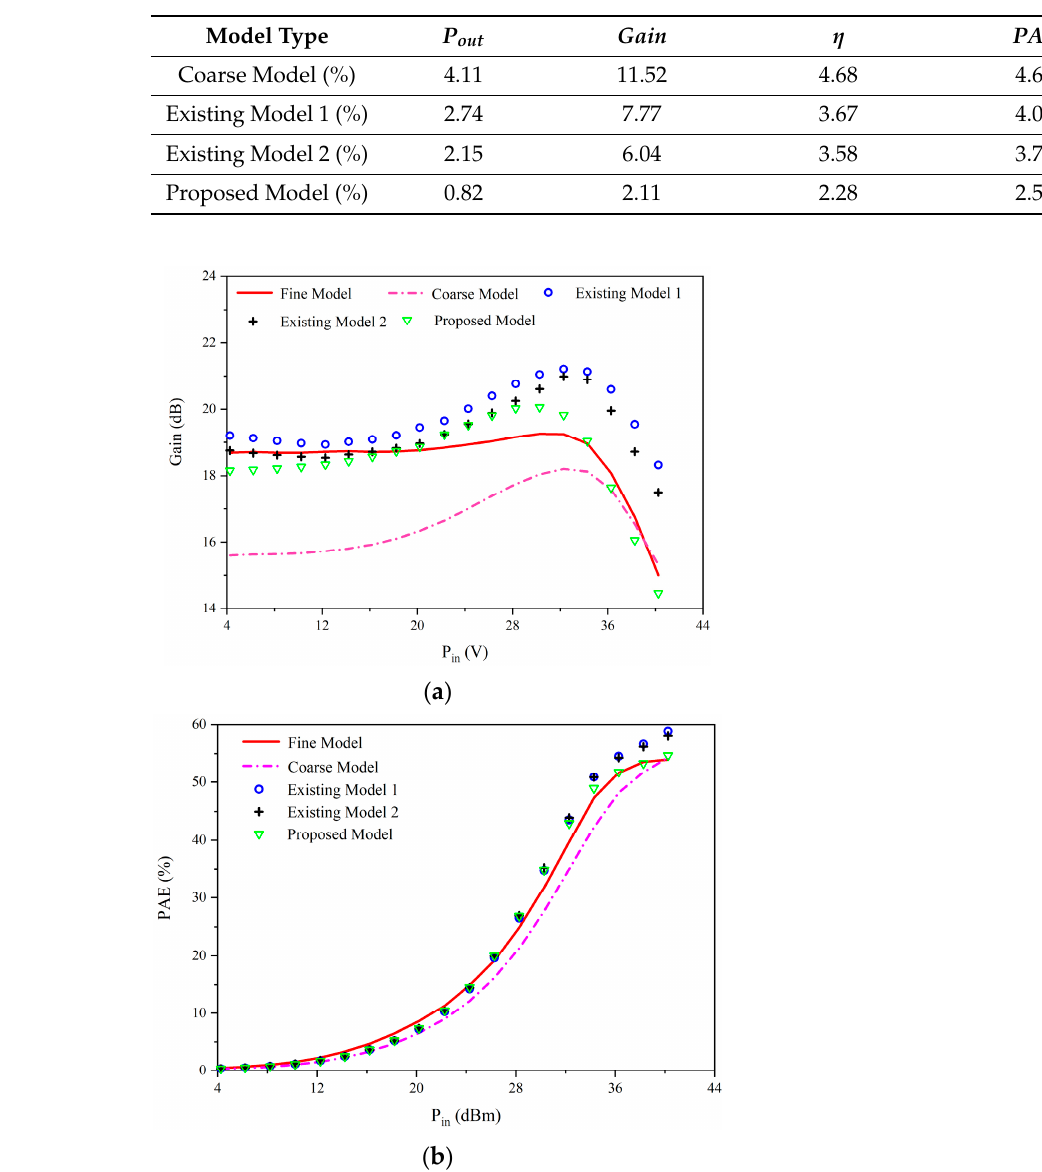
Figure 6. The parameters comparison between the models and the fine data. ( a ) Gain versus P in . ( b ) PAE versus P in .